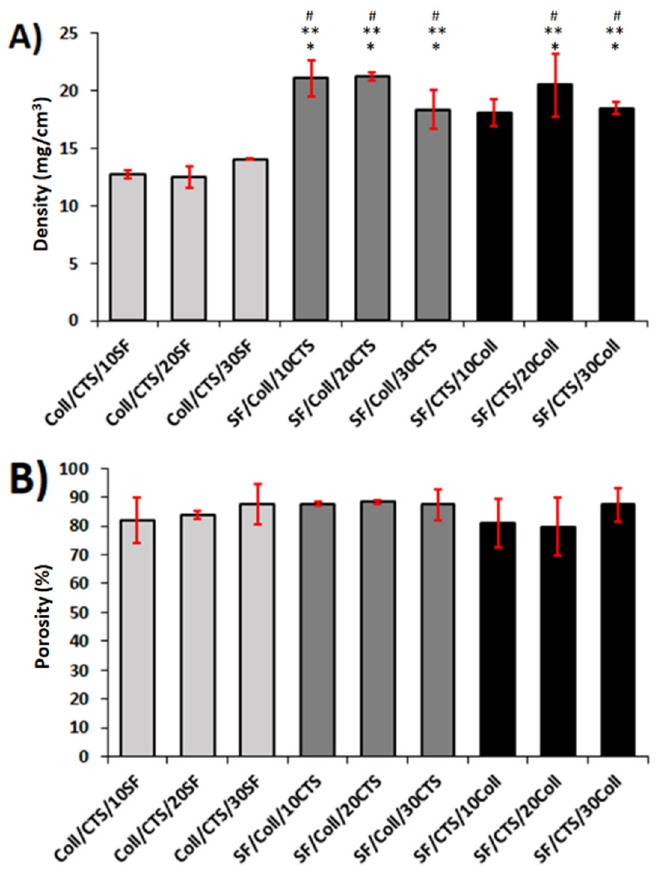
Figure 2. The density ( A ) and porosity ( B ) of 3D scaffolds ( n = 3, mean ± SD, * significantly different vs. Coll/CTS/10SF, ** significantly different vs. Coll/CTS/20SF, # significantly different vs. Coll/CTS/30SF, p < 0.05).